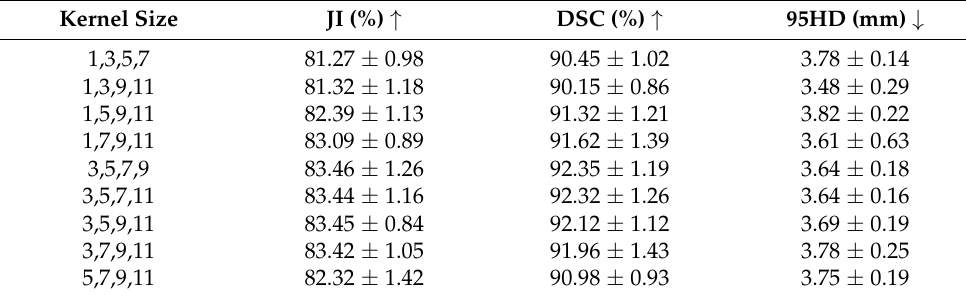
Table 3. Segmentation results on different levels of convolution